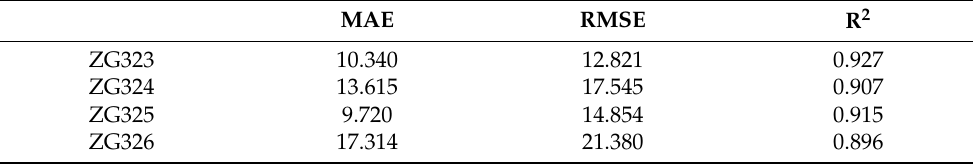
Table 6. Prediction accuracy of cumulative displacement in ZG323 to